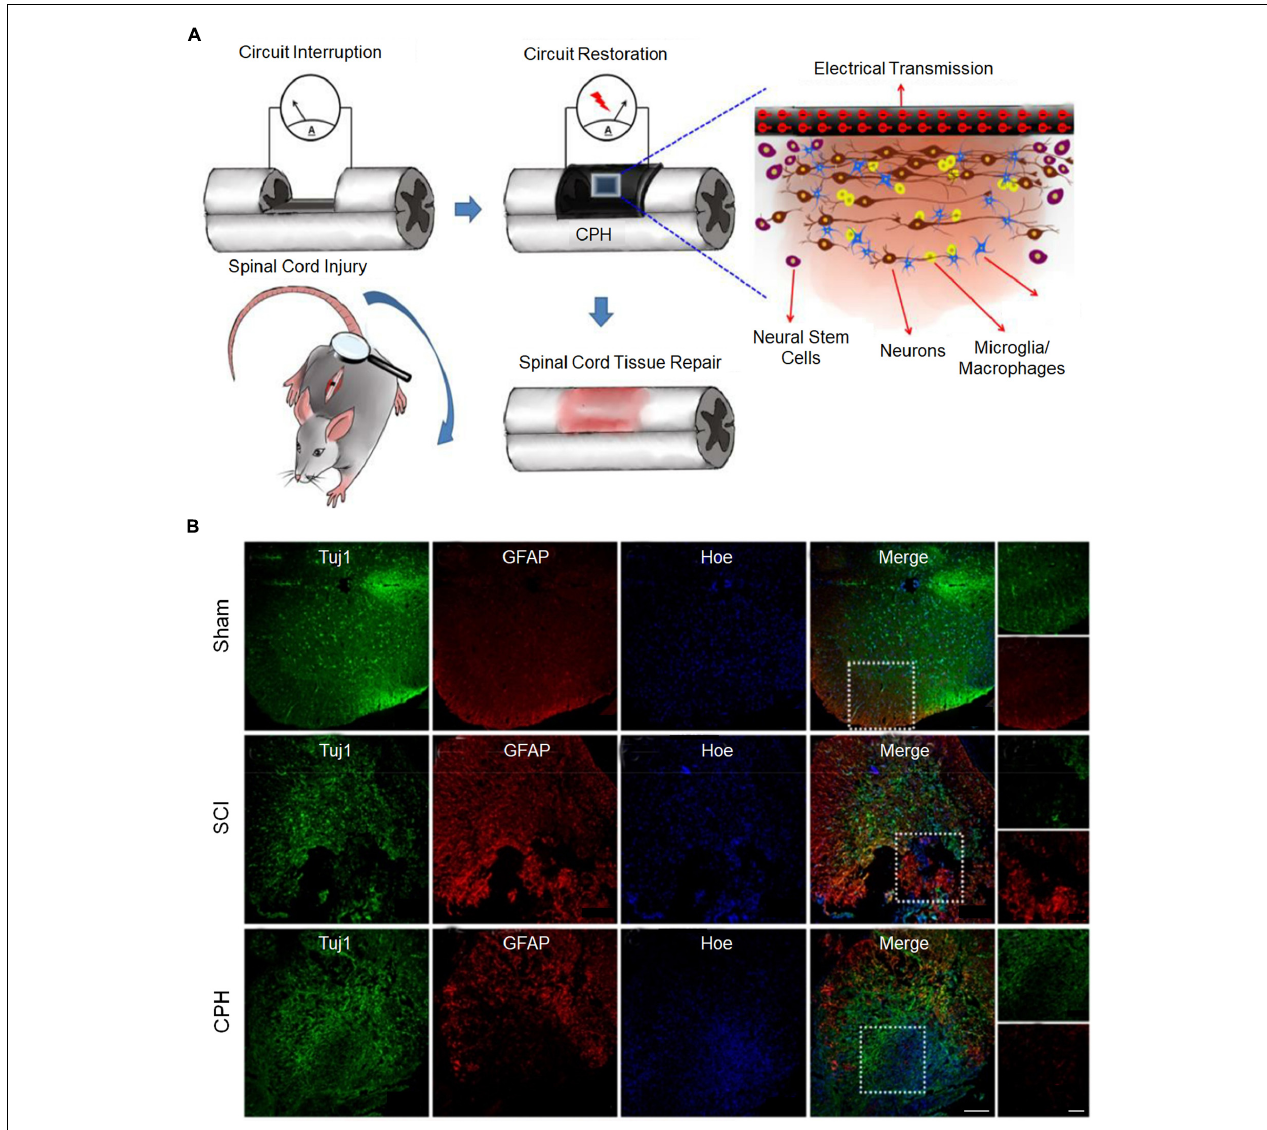
FIGURE 4 | Conductive hydrogels repair spinal cord injury (Zhou L. et al., 2018). (A) The possible mechanism for conductive hydrogel to promote tissue regeneration is to restore the interrupted spinal circuit through endogenous neurogenesis. (B) Immunohistofluorescence images of transverse spinal cord sections obtained from animals in the sham, injury, and hydrogel groups at 6 weeks. Scale bars = 200 and 100 µ m, respectively. Figures reproduced with permission from the references listed.